Question: Summarize what this figure shows in one sentence.
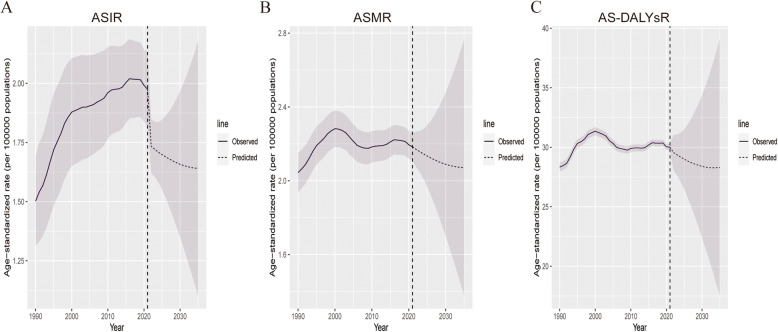
Answer: Predicted trends for multiple myeloma (MM) disease burden indicators from 2021–2035. A Projected ASIR (incidence per 100,000 population). B Projected ASMR (mortality per 100,000 population). C Projected AS-DALYsR (disability-adjusted life years per 100,000 population)